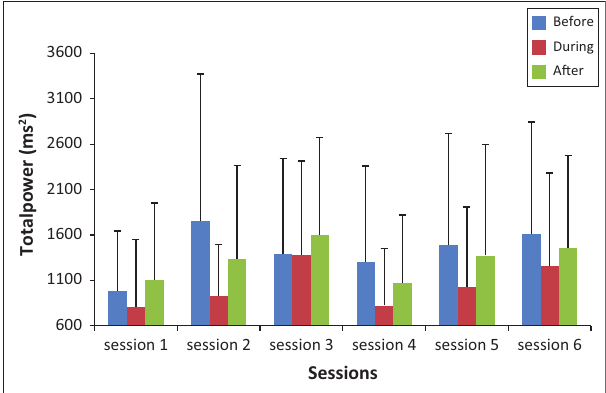
FIGURE 2: Total power before, during and after therapeutic horseback riding (THR) over six sessions.